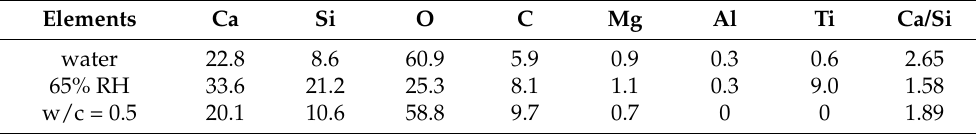
Table 1. EDX analysis of hydration products under different conditions after 24 h (at.%).